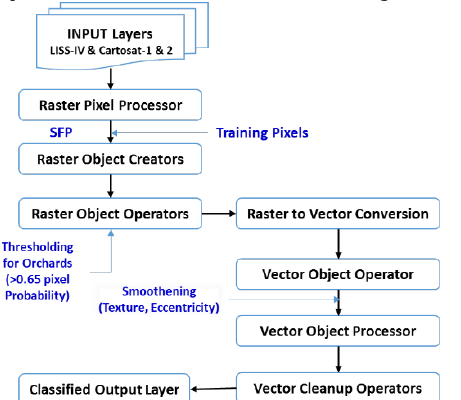
Figure 4. Different aged orchards on satellite image (Google Earth